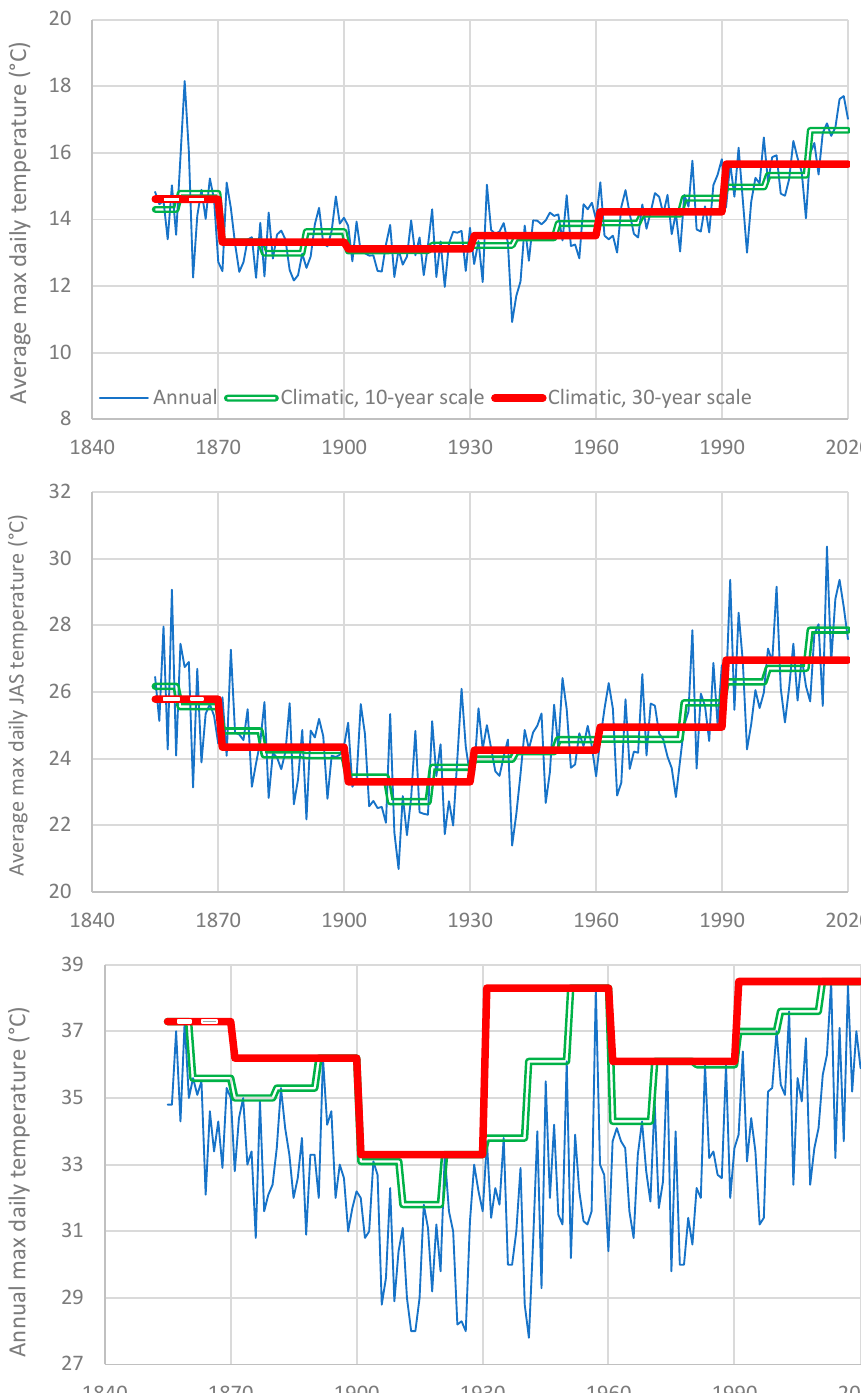
Figure A1. ( upper ) Evolution of annual average of maximum daily temperature in Vienna, as a climatic element, seen at the annual and the climatic time scales of 10 and 30 years; ( middle ) as in upper panel but for a time window of the three summer months, JAS; ( lower ) as in upper panel but for the annual maximum of maximum daily